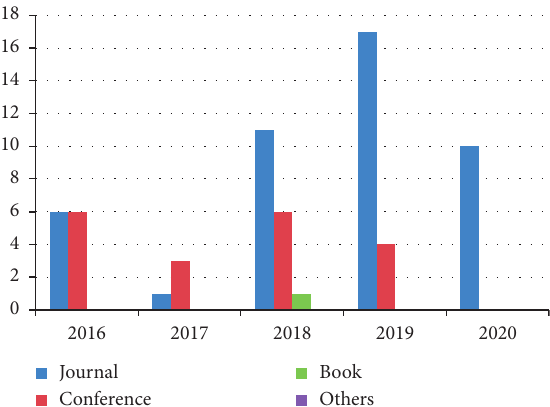
Figure 19: Year and article type.